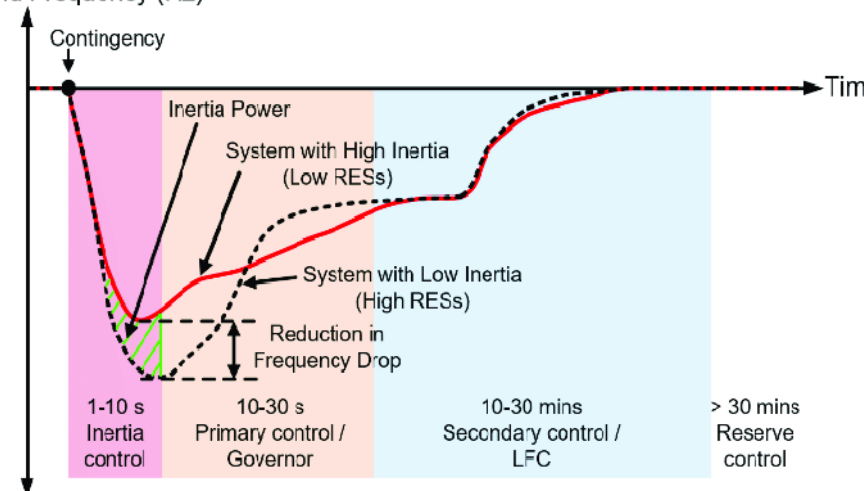
Figure 1. Time intervals of frequency response during a contingency. Reprinted from